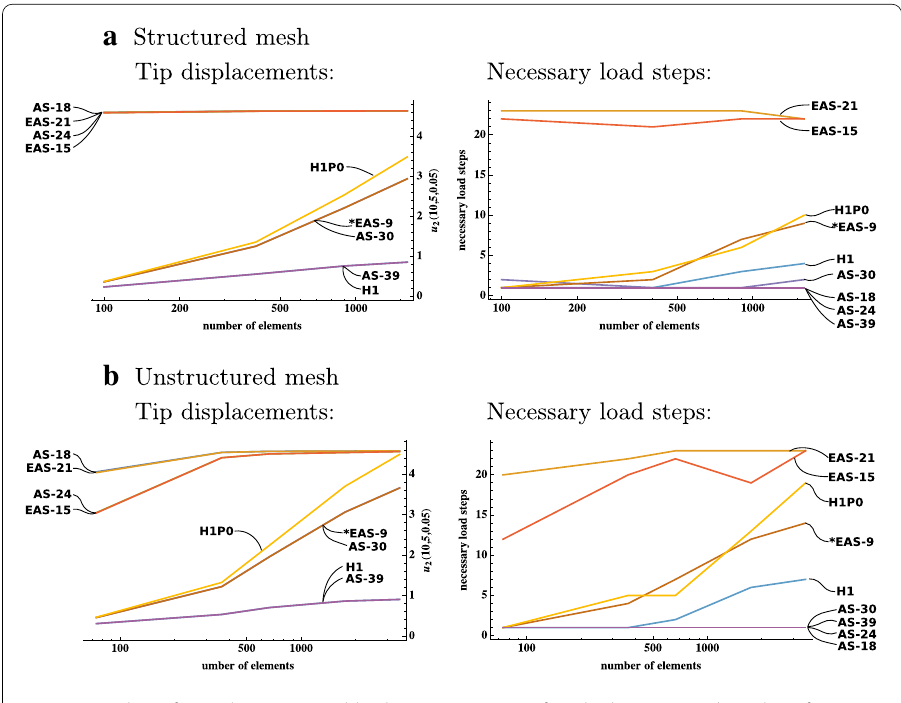
Fig. 12 Bending of a nearly incompressible plate; convergence of tip displacement and number of necessary load steps over the number of elements for a structured ( a ) and an unstructured ( b ) mesh refinement